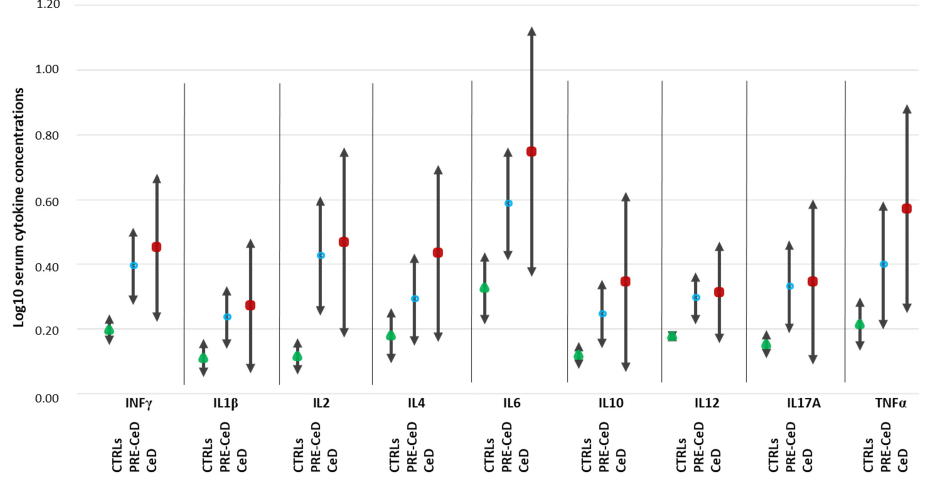
Figure 1. Serum cytokines in controls, celiacs before the onset of disease and active celiacs at time of diagnosis. The serum cytokine concentrations were detected in 83 serum samples from 20 celiac patients (41 samples) before (PRE-CeD) and after the diagnosis (CeD) and 26 controls (CTRLs, 42 samples) by multiplex protein quantitation using the Luminex instrument platform. The raw values of cytokine levels were transformed by the decimal logarithm. Geometric means of log10-transformed values ( ▪ ) are shown with 95% confidence intervals ( ↨ ).